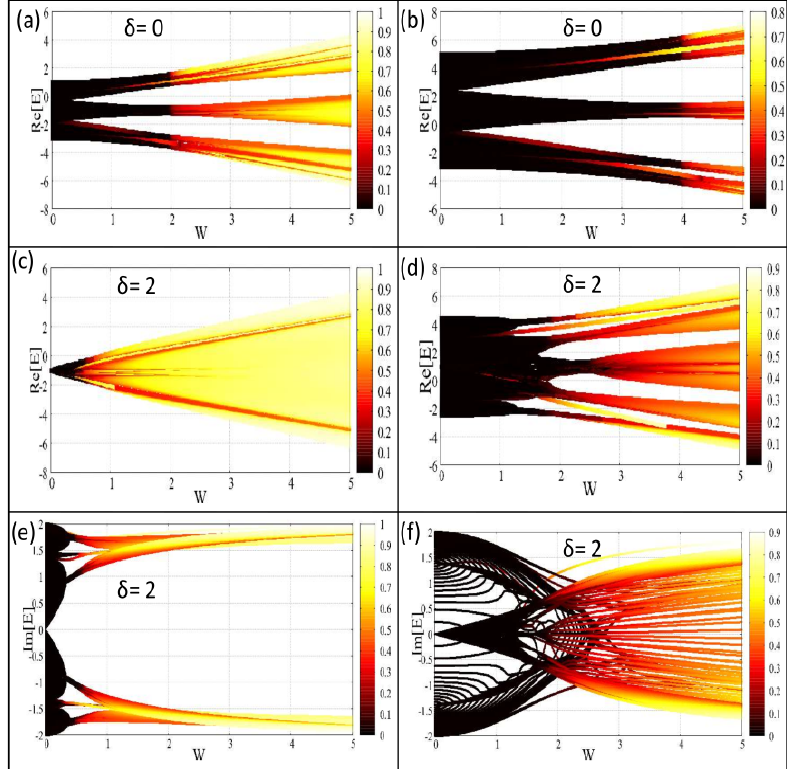
Figure 4. (Color online). Energy resolved inverse participation ratio. Density plot of inverse participation ratios of different eigenstates as functions of the Aubry–André–Harper modulation strength W and the eigenvalues for the BT-I ladder, where the first ( a , c , e ) and second columns ( b , d , f ) are associated with the chain-2 and chain-1, respectively. For δ = 0, we only have real eigenvalues, whereas for non-zero δ , we have both real and imaginary parts, and we plot them into two separate rows (second and